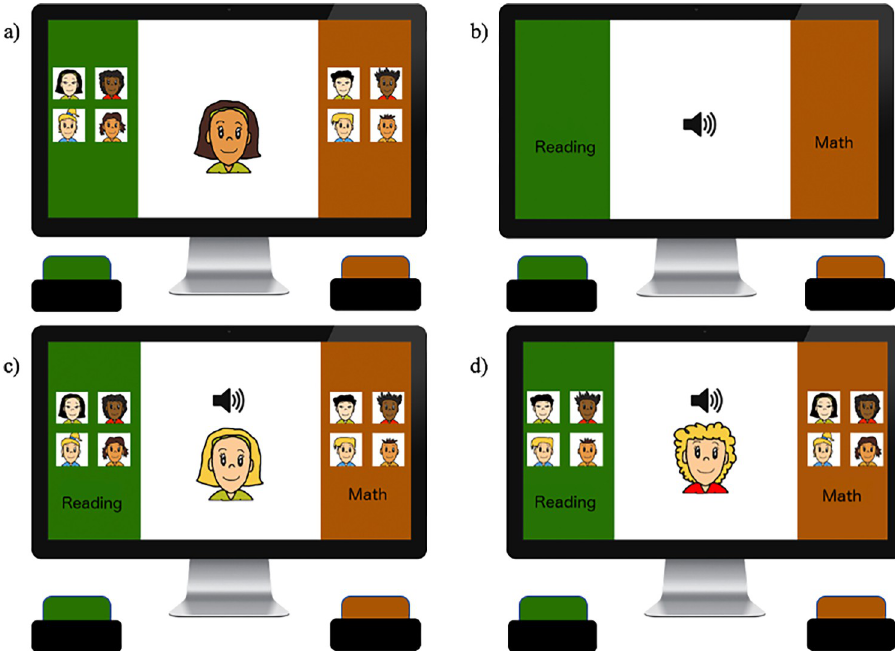
Fig 1. Schematic of implicit stereotype measure. A) and b) practice blocks: participants categorize only stimuli from the target categories (gender) or the attribute categories (math vs. reading) separately. C) and d) critical blocks: participants categorize stimuli from both target and attribute categories, one at a time, with two categories each mapped on one of two response buttons in stereotype-congruent (c) vs. stereotype-incongruent pairings (d).